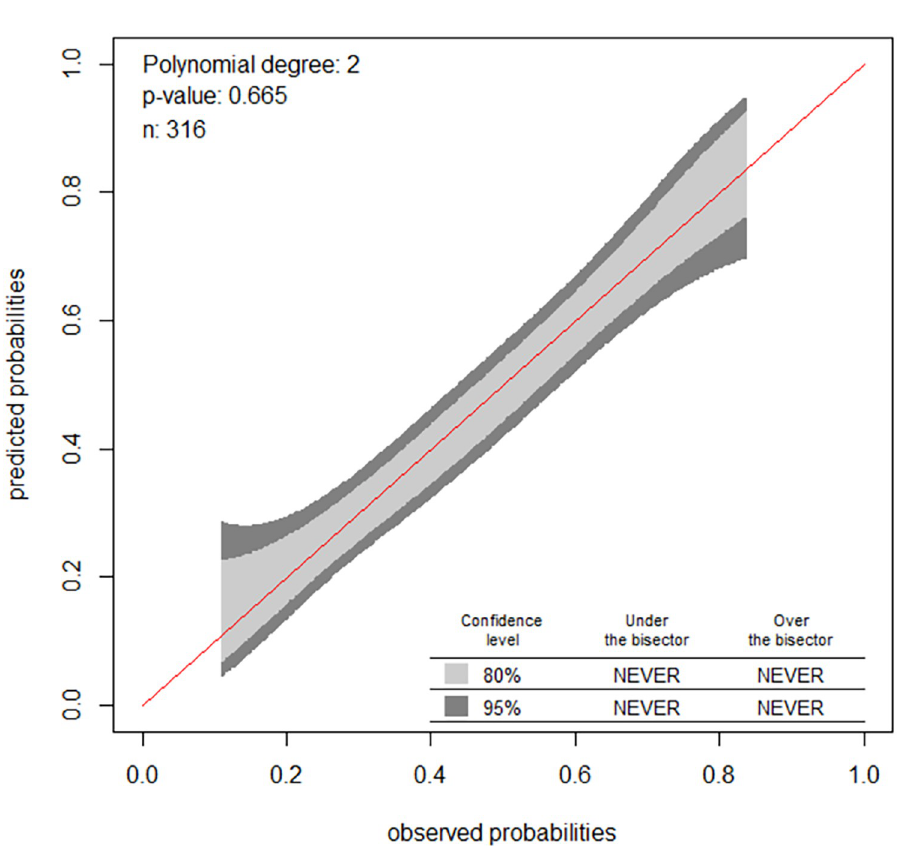
Fig 5. Observed versus predicted probabilities of late culture conversion in a sample.